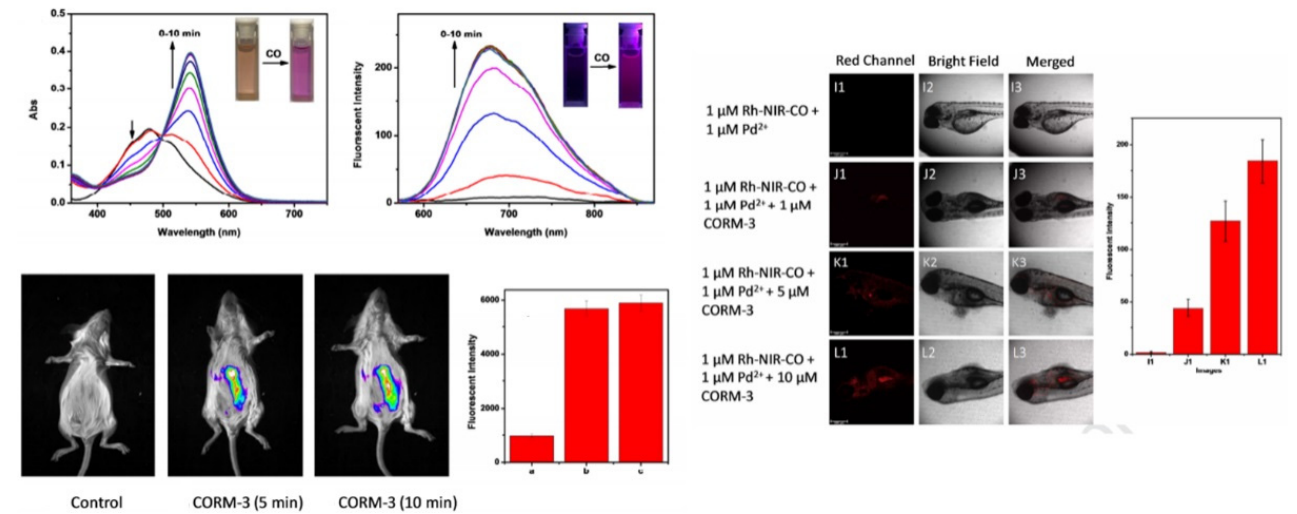
Figure 9. The spectra of probe 15 and its fluorescence imaging of CO in mice and zebrafish, respec- tively. Copyright (2020) Elsevier Ltd. [31].